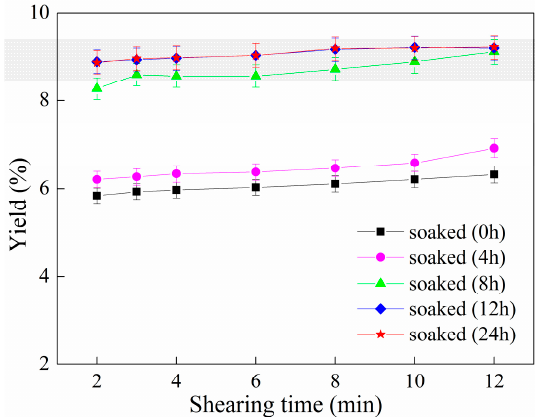
Figure 5. Relationship of soaking time and ultrafine shearing time on yield of C-PC. Error bars indicate standard deviations of the means ( n = 3).